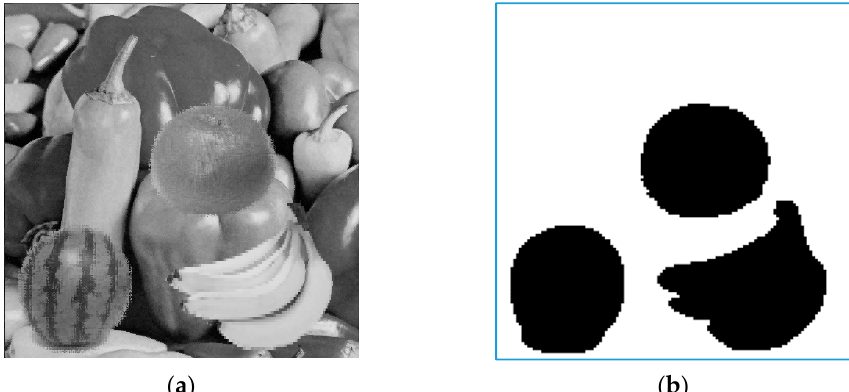
Figure 8. The tampering of Peppers image. ( a ) The tampered image; ( b ) The tampered regions.